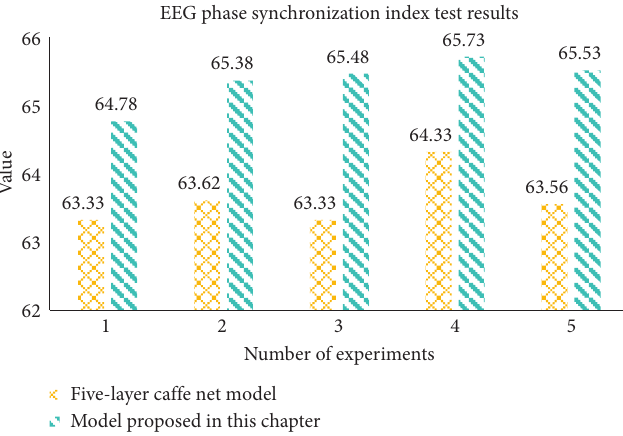
Figure 12: EEG phase synchronization index t -test results. Table 11: The emotional effect of ERP